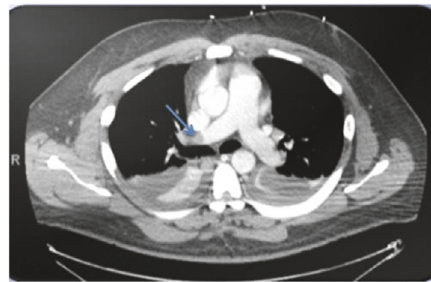
Figure 2: CT Chest demonstrating embolus in the right main pulmonary